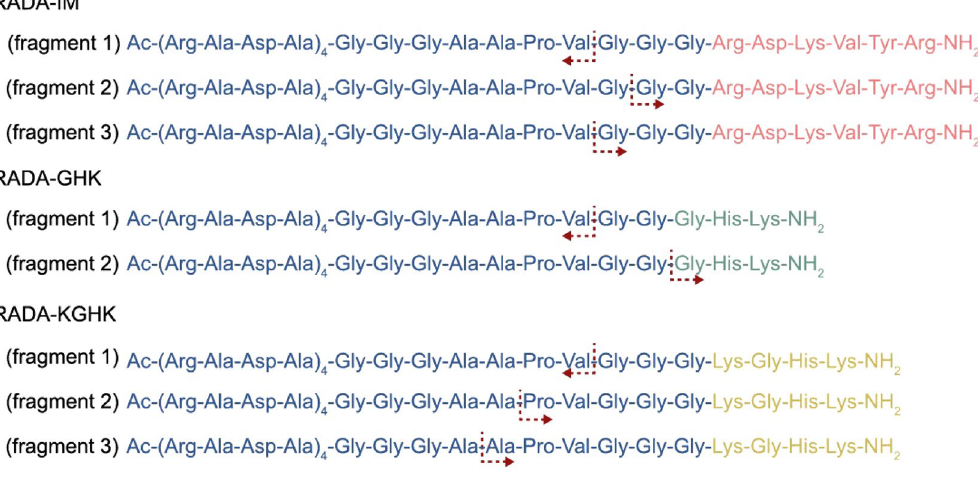
(Fig. 3A), which means a lower ratio of β-sheet formation in the hybrid peptides. We subsequently examined the thermal stability of the RADA hybrids using CD. Figure 3B shows the CD spectra of peptides corresponding to mean molar ellipticities, [θ] 196 nm, as a function of the temperature, over a range of 4–100 °C. Above 100 °C, the curve was extrapolated due to limitations caused by water, as above this temperature it would evaporate and the concentration of peptide would drastically change. The first disruption of the β-sheets were observed around 38 °C for RADA, 52 °C for RADA-IM, 61 °C for RADA-KGHK, and 65 °C for RADA-GHK, as indicated by decreases of molar ellipticity. The transition temperatures, representing the state in which half of the structure forms a β-conformation and half is disordered, were 68 °C for RADA, 95 °C for RADA-IM, 94 °C for RADA- GHK, and about 92 °C for RADA-KGHK. In the next step, analysis was carried out to confirm the presence of β-structures that form a complex with thioflavin T (ThT). This technique, which is used to detect amyloid fibrils, has successfully been applied to image RADA16-I nanofibers 55 . Figure 4 demonstrates that thioflavin T formed a complex with the studied RADA fibres, which was indicated by fluorescence intensity at 482 nm. The differences between the fluorescence intensities reflected different ratios of formation of β-sheets. The peptide elongated with KGHK showed a lower potential for β-sheet formation in comparison to RADA16- I itself. Interestingly, RADA-IM, a peptide longer than RADA-KGHK by only two amino acid residues, has a similar β-sheet formation potential to RADA16-I (Fig. 4).